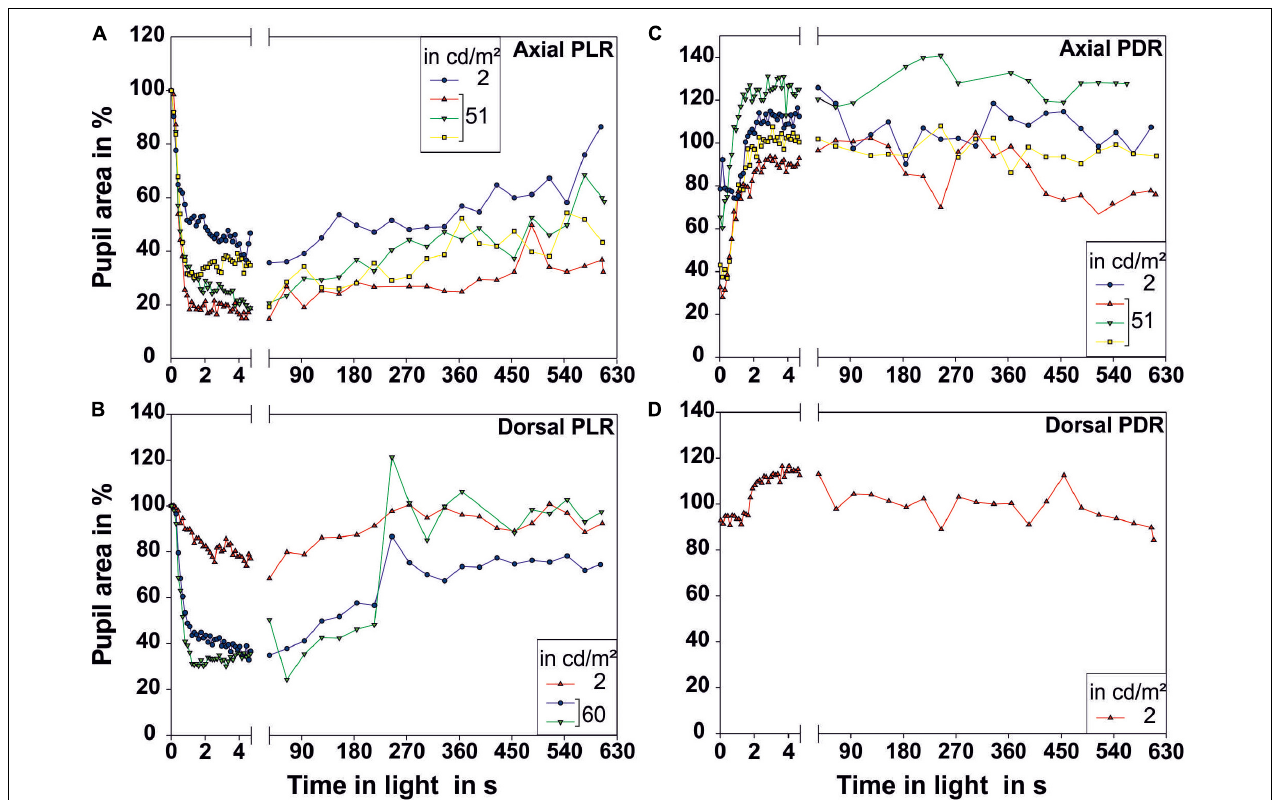
FIGURE 4 | Pupillary reactions measured over a prolonged time period of 10 min. (A,B) Illustrate the pupillary light reaction (PLR) for (A) axial ( N = 4) and (B) dorsal illumination ( N = 3). (C,D) Illustrate the pupillary dark reaction (PDR) for (C) axial ( N = 4) and (D) dorsal illumination ( N = 1). Only one low and one higher luminance were chosen for these long-term recordings. All measurements performed are plotted in this figure. The pupil size on the first frame of the light period was taken as 100% pupillary area. Each data point represents one measurement of pupillary area. The luminance of the light source in cd/m 2 measured from the distance at which the eye of the octopus had been during measurement is indicated in the legend. Light onset is zero on the time